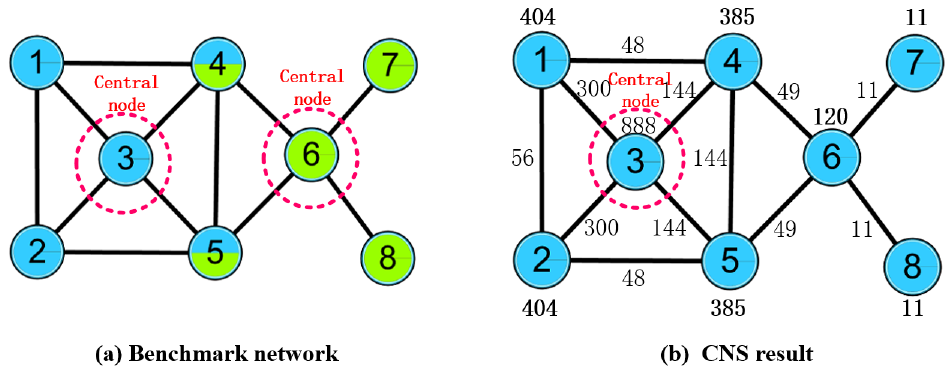
Figure 1. Example of the limitation of the central node selection (CNS) algorithm.